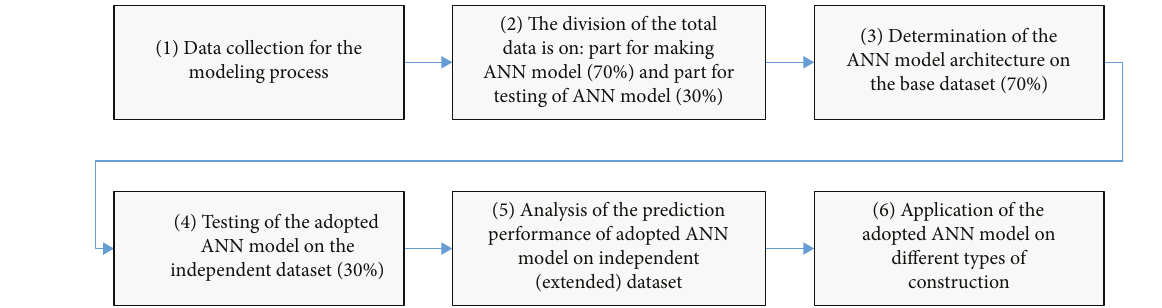
Figure 3: Diagram of the research timeline. Table 1: Input values for the modeling process.